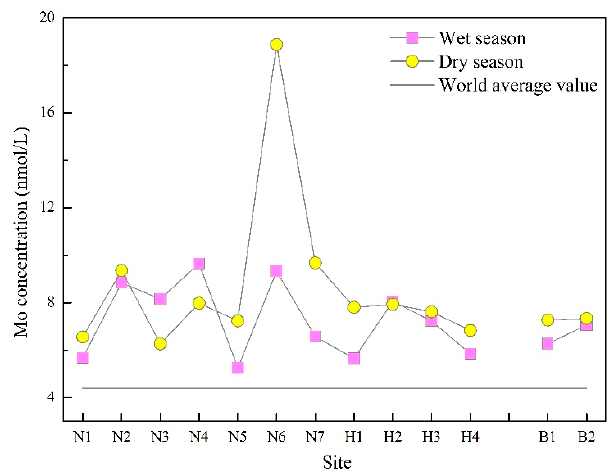
Figure 2. Seasonal and spatial variations in dissolved Mo concentrations of the upper Xijiang.